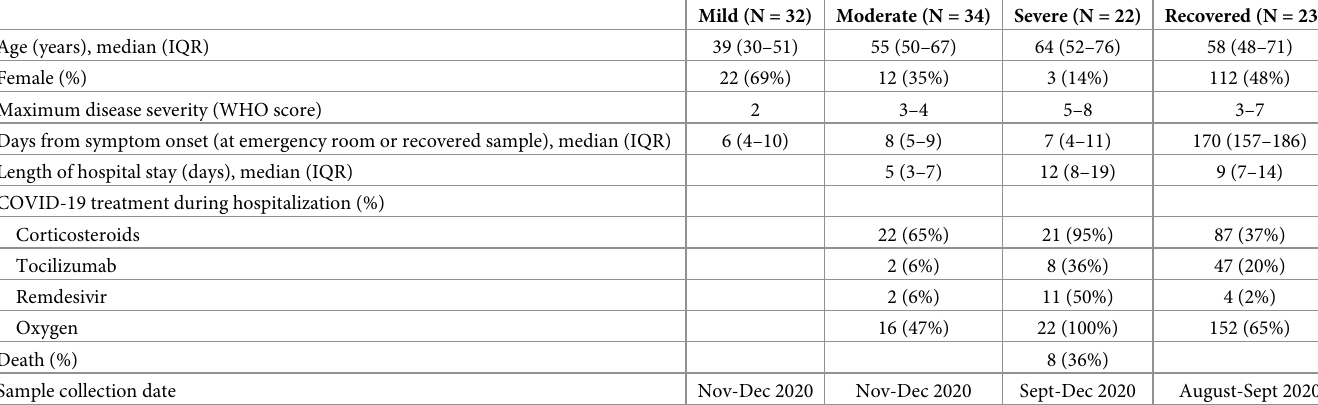
Table 1. Demographic and clinical characteristics of the